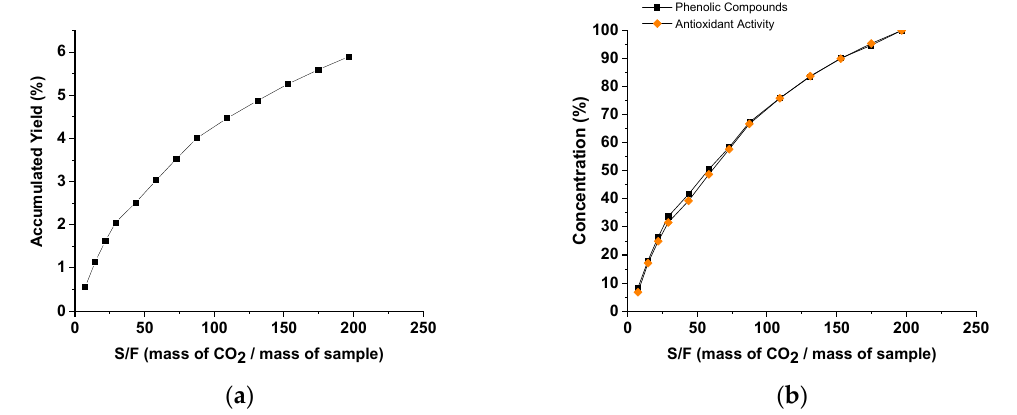
Figure 2. Results obtained for the overall extraction curves for ( a ) yield in mass (g) of accumulated extract versus S/F and ( b ) yield of phenolic compounds (%) and antioxidant activity (%) versus S/F (mass of CO 2 /mass of sample) (cumulative values ).